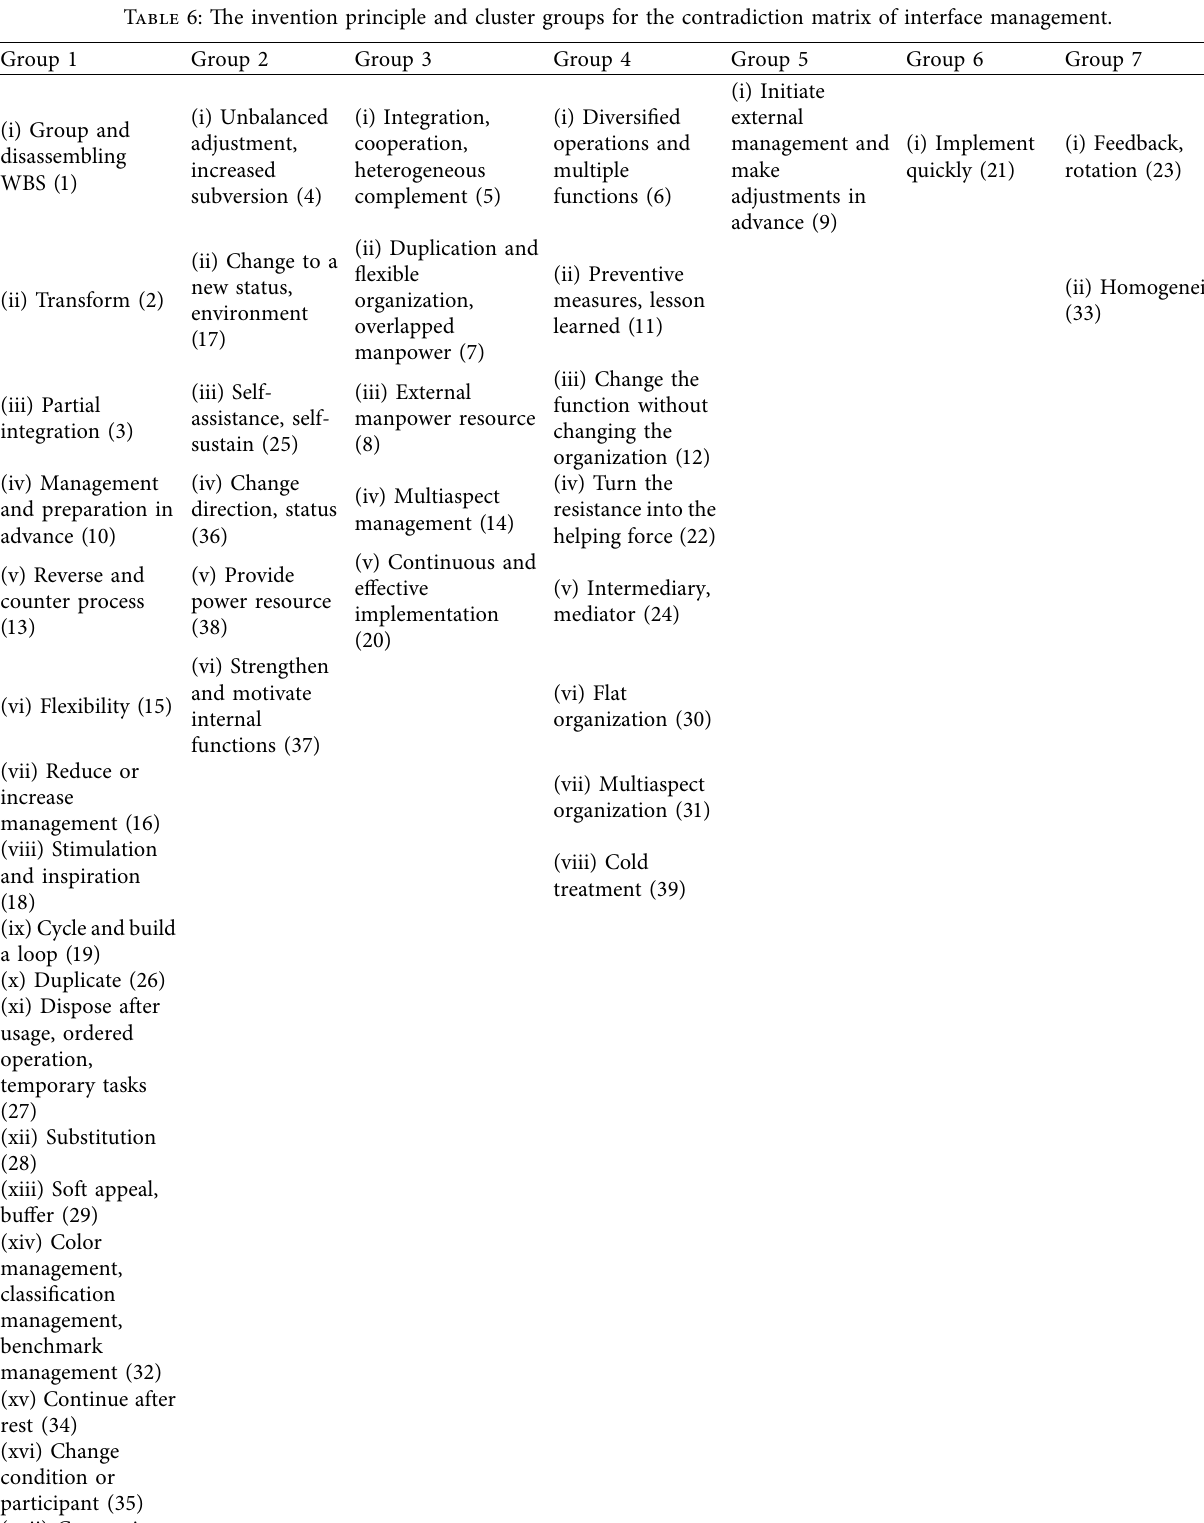
Table 6: The invention principle and cluster groups for the contradiction matrix of interface management. Group